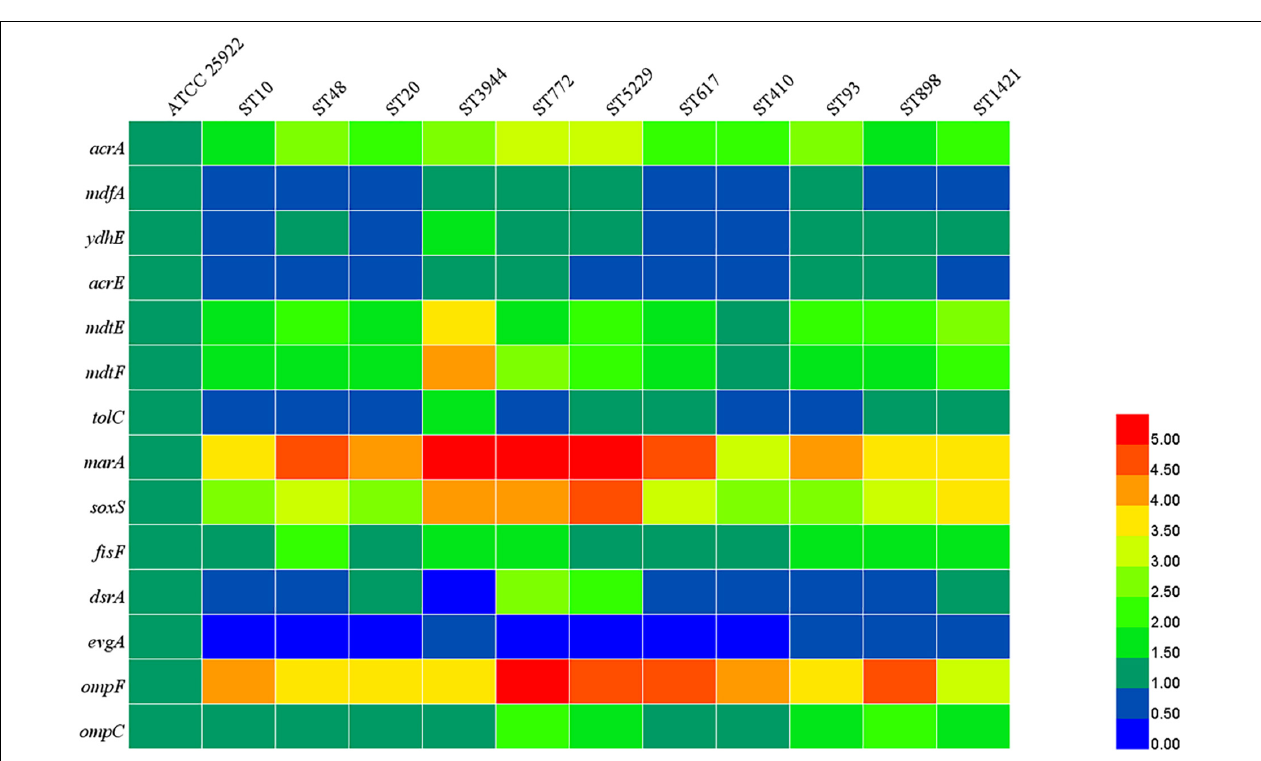
FIGURE 3 | Minimal spanning tree of mcr-1- positive E. coli. Each circle corresponds to one ST and the size of each circle indicated the number of isolates in this ST type.